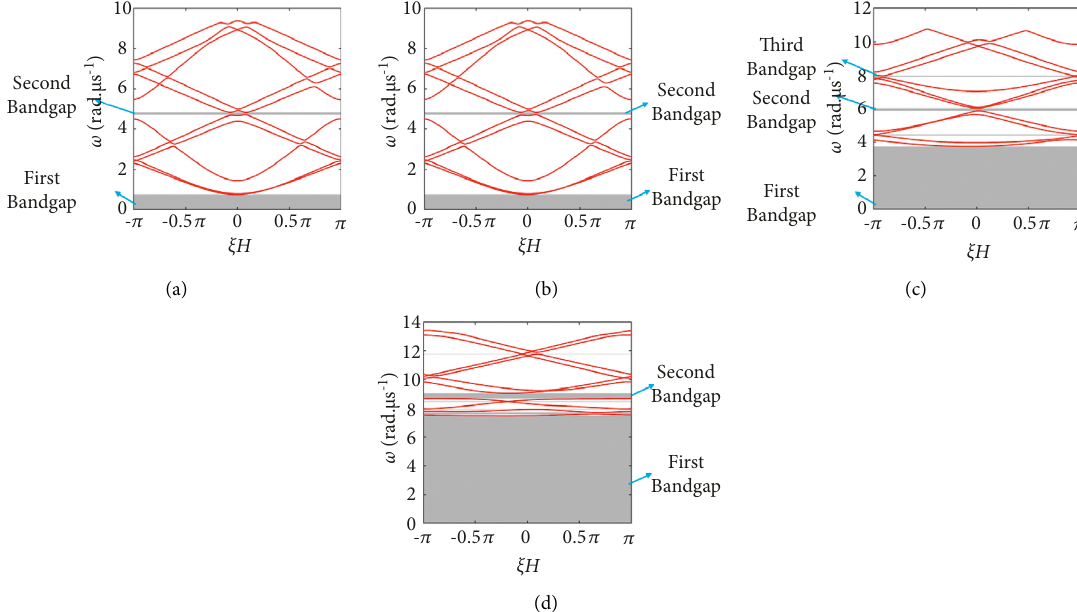
Figure 9: Dispersion curves (red solid lines) and bandgaps (shaded segments) for a periodically infinite multilayered structure, where (a) κ H � 0 . 1, (b) κ H � 1, (c) κ H � 5, and (d) κ H �